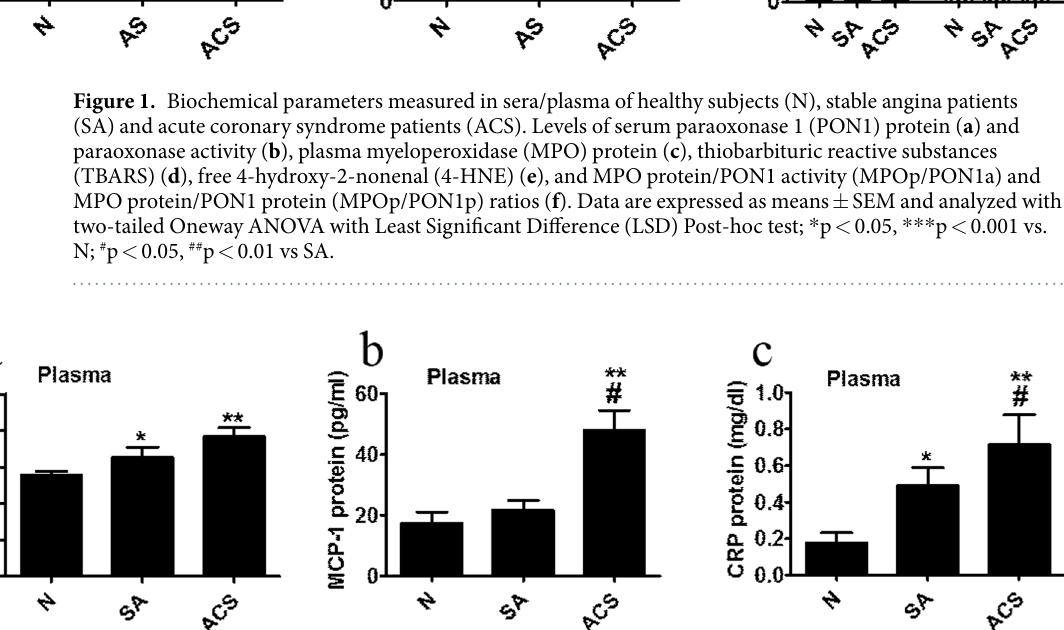
with the increased oxidative status in plasma and HDL proteins of ACS versus SA patients. However, the BLR model including individually PON1 activity, TBARS or MPO levels, with no other covariates added, did not pro- vide a statistically significant differentiation between the ACS and SA groups. The BLR model including PON1 and TBARS levels without any adjustment for age or gender as covariates resulted in a significant delineation between ACS versus SA patients with a moderate accuracy of around 68% (p = 0.026). We also assessed some relevant pro-inflammatory molecules present in the plasma of CAD patients and N subjects. The soluble vascular cell adhesion molecule 1 (sVCAM-1) concentration was increased in all CAD patients’ compared to N subjects (SA, 17%, p = 0.041; ACS, 38%, p = 0.0072) (Fig. 2a). Monocyte chemoattract- ant protein 1 (MCP-1) levels were higher in ACS compared to SA and N subjects (120%, p = 0.026, and 170%, p = 0.0063 respectively) (Fig. 2b). The C reactive protein (CRP) levels were considerably augmented in CAD